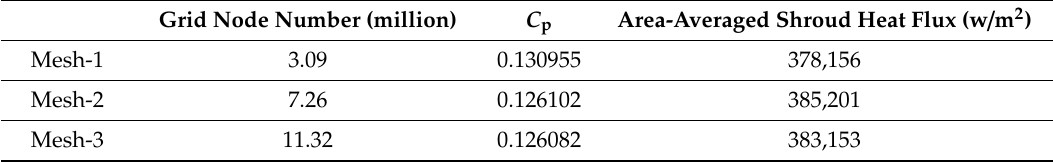
Table 2. Mesh sensitivity analysis of S2 without